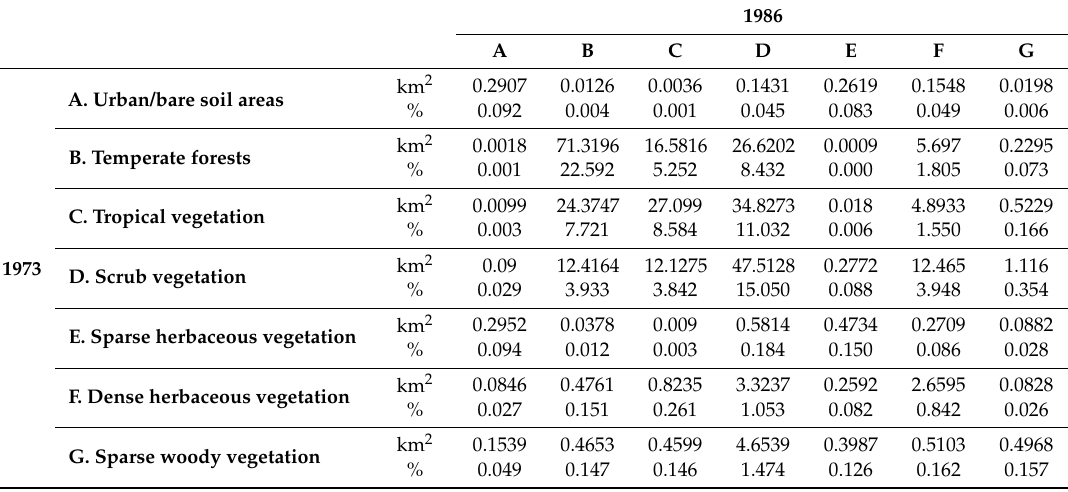
Table 9. Matrix of land use-cover changes from 1973 to 1986, in Natural Protected Area Altas Cumbres (NPAAC). Victoria, Tamaulipas,